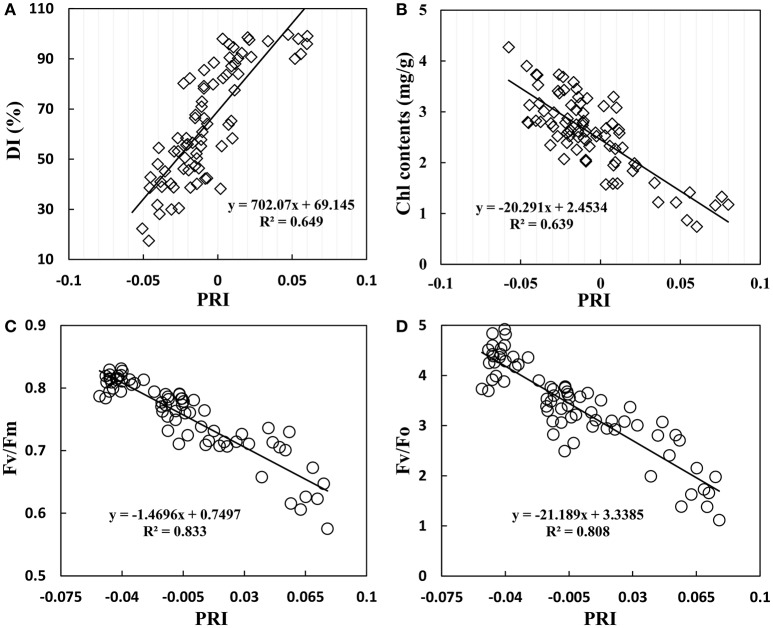
Relationship between DI (A), leaf chlorophyll contents (B), Fv/Fm (maximum photochemical efficiency of PSII) (C), Fv/Fo (potential activity of PSII) (D), and the photochemical reflectance index (PRI) in winter wheat. Data points from Experiments1–3.